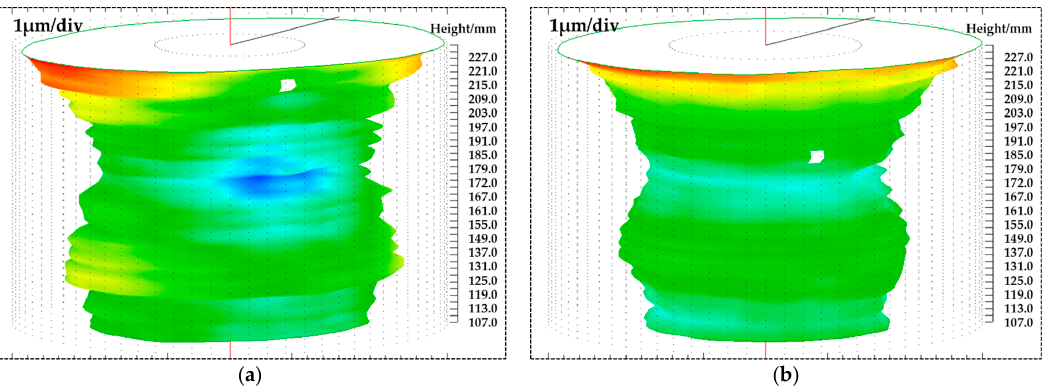
Figure 16. Cylindricity diagrams: ( a ) Before figuring process; ( b ) after figuring process.